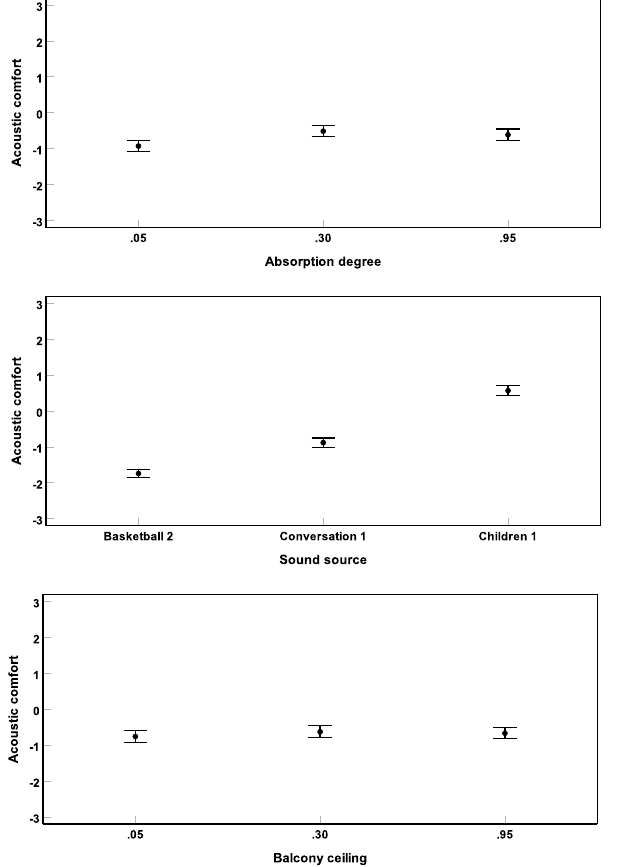
Figure 10. Results of Experiment 3: Mean acoustic comfort ratings across subjects and their 95% confidence intervals are shown for different absorption degrees α w ( above ), sound sources ( middle ), and absorption degrees of the balcony ceiling α w ( below